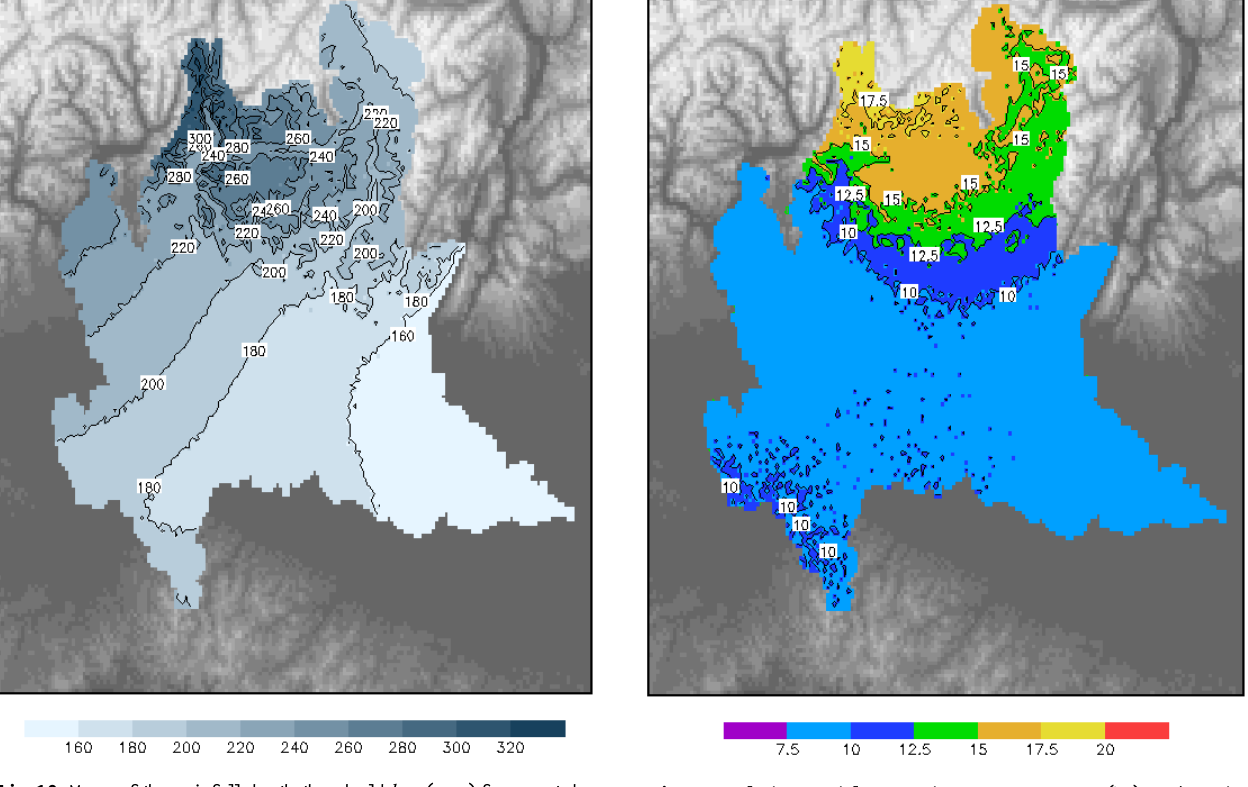
Fig. 11. Relative partial uncertainty component ρ ξ (%) on the rain- fall depth threshold h T,D for return period T = 200 yr (and for any duration D ), due to the uncertainty on the estimate of the parameter ξ